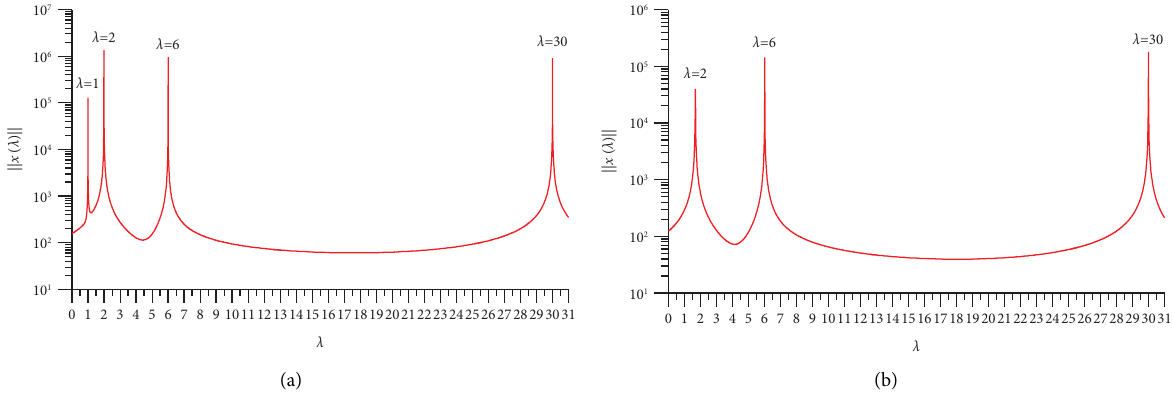
Figure 9: For Example 7 of a nonsymmetric matrix, (a) with m � 4 showing four picks of ‖ x ‖ , corresponding to eigenvalues 1, 2, 6, and 30, and (b) with m � 3 showing three picks of ‖ x ‖ , corresponding to eigenvalues 2, 6, and 30.